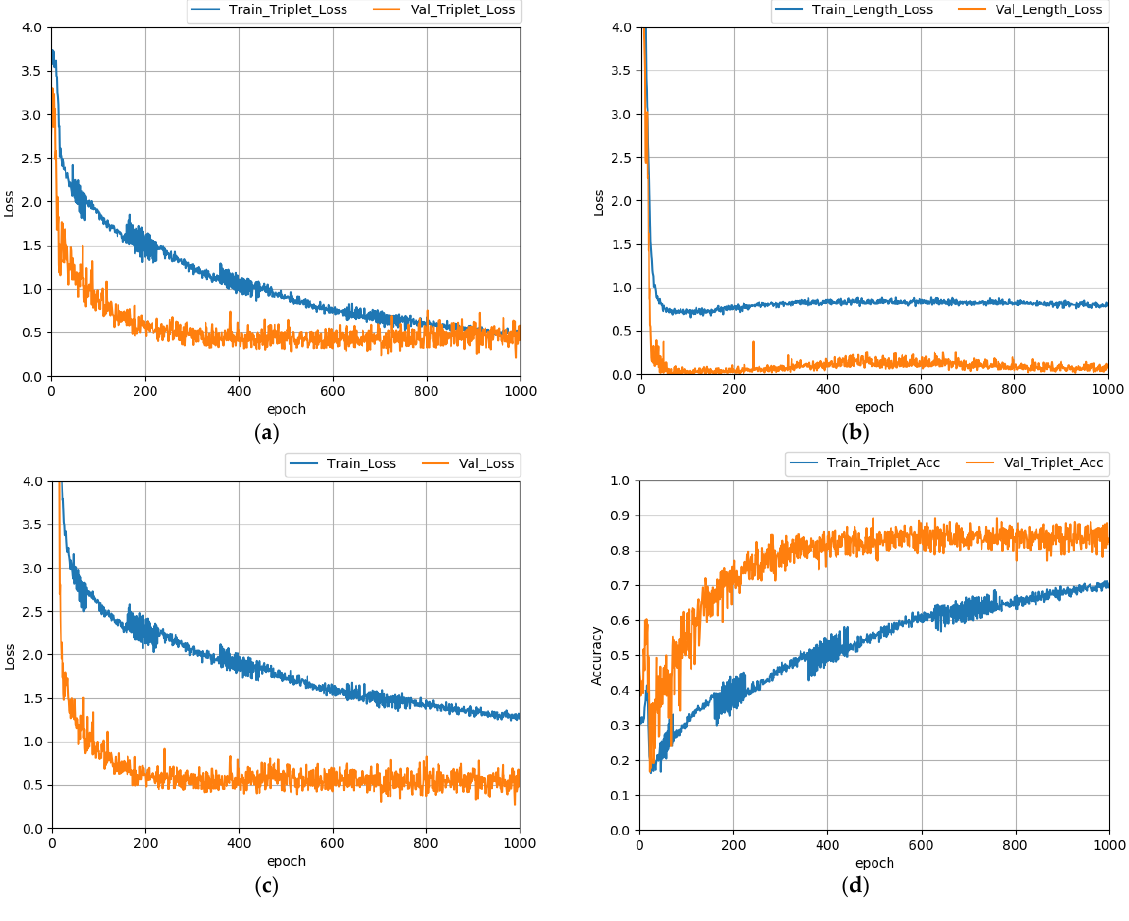
Figure A4. Stage 1 training result of the proposed learning method combined with the triplet loss. ( a ) triplet loss; ( b ) vector length loss; ( c ) total loss; ( d ) triplet accuracy.